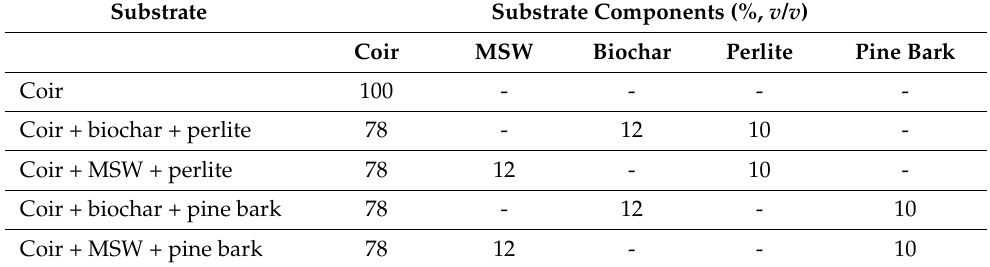
Table 8. Substrate components (%, v/v